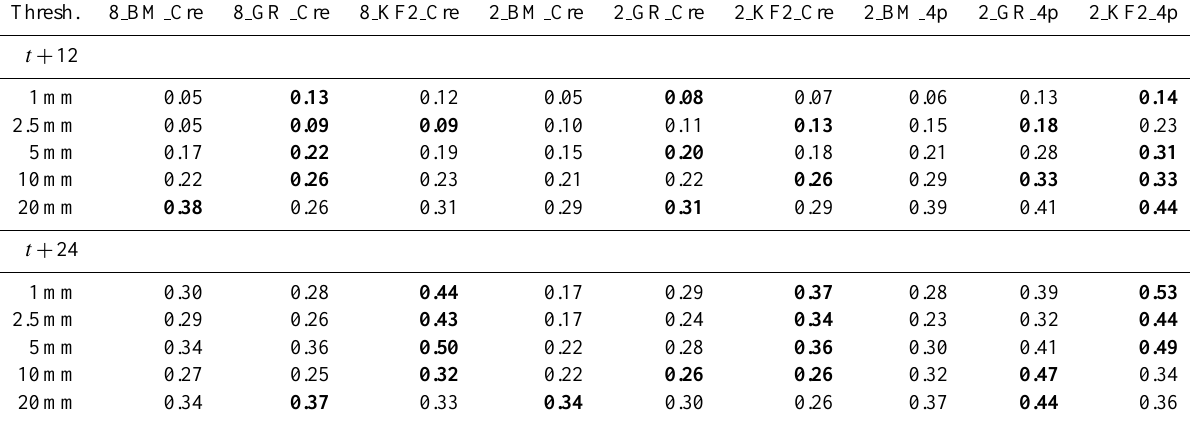
Table 8. As in Table 2 but for Equitable Threat (ET) score ( − 1/3–1) and three different CPSs: Betts-Miller, Grell and Kain-Fritsch-2.